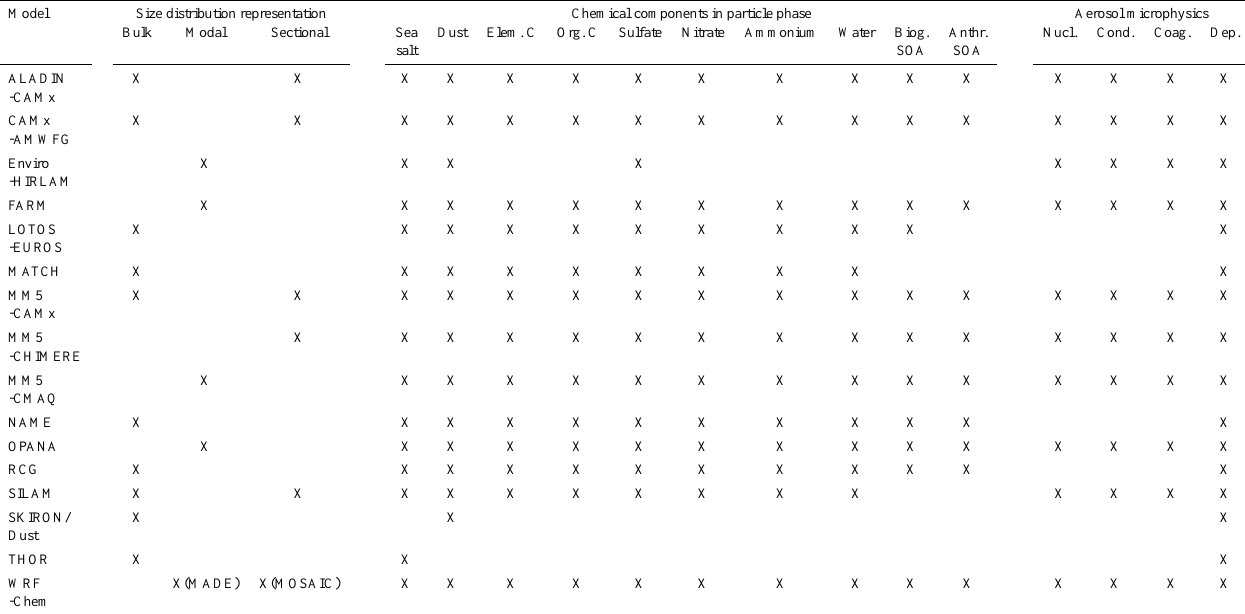
Table 6. The treatments for aerosol particles in the CWF models: size distribution, chemical composition and aerosol microphysics.